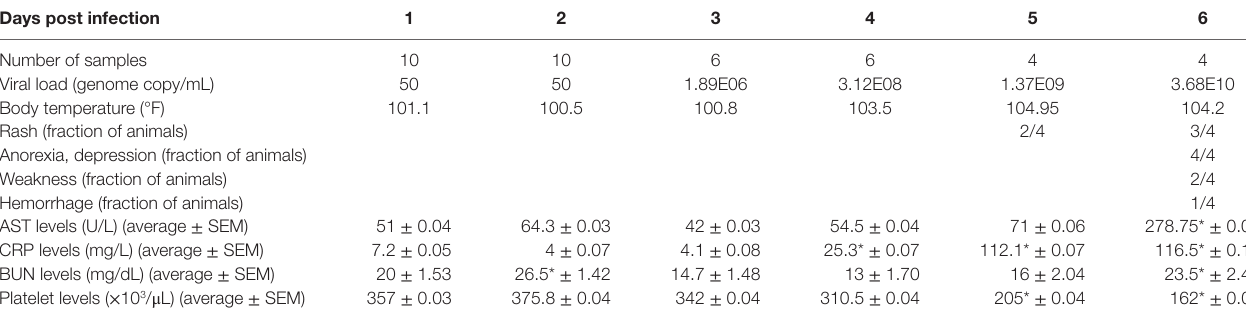
TaBle 1 | Summary of average clinical data and flow cytometry data during ZEBOV-Makona infection. Days post